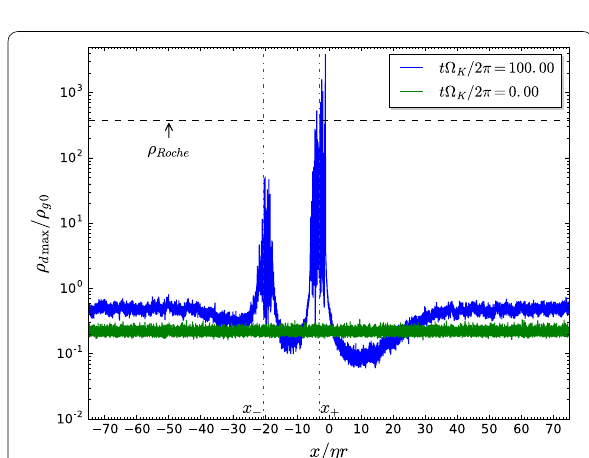
Fig. 3 Radial distribution of maximum dust density ρ d ,max . The horizontal dotted line shows the Roche density ρ Roche at 1 AU from